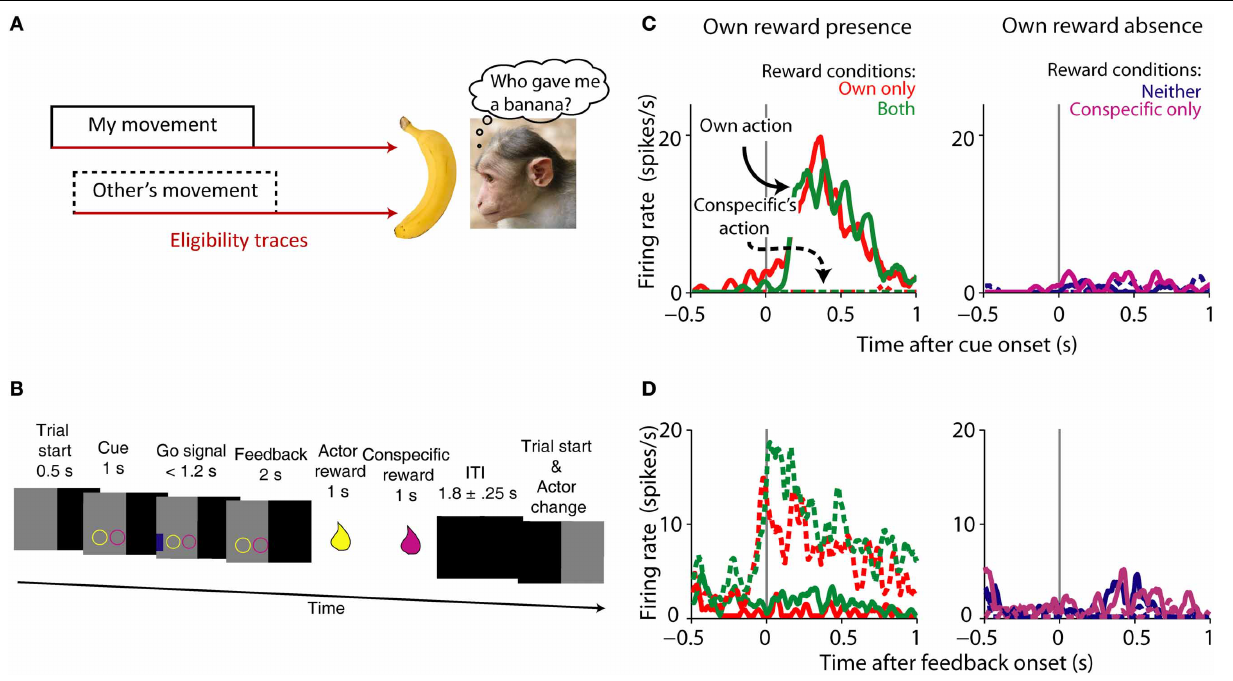
FIGURE 4 | Agency credit assignment cartoon and striatal neurons coding social action and own reward. (A) Once the monkey receives a banana it needs to know which action produced reward to assign credit. The action can be its own (solid lines) or someone else’s (dashed lines). Many actions take place before reward is delivered, therefore looking at a memory of each action or eligibility trace (brown arrows) can solve the agency credit assignment problem. (B) Task sequence for the actor: shape of conditioned cue predicted absence or presence of reward for each animal. Appearance of a subsequent blue go signal was followed by key